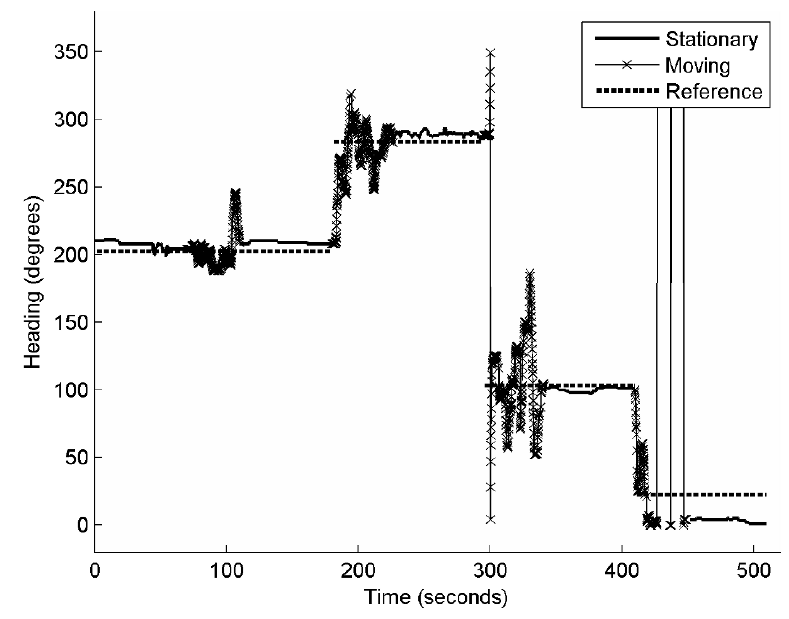
Figure 8. The heading measurements of the smartphone compass and the corresponding reference in an indoor